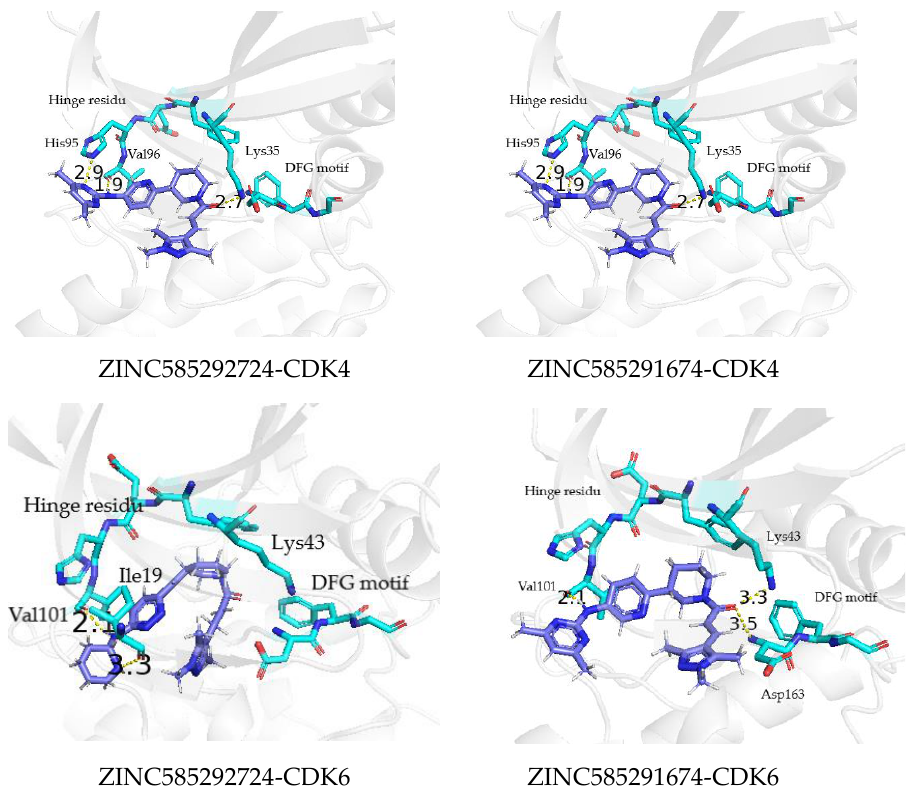
Figure 13: The binding mode of ZINC585292724 and ZINC585291674 to the ATP binding pocket of CDK4 and CDK6 at 200 ns.